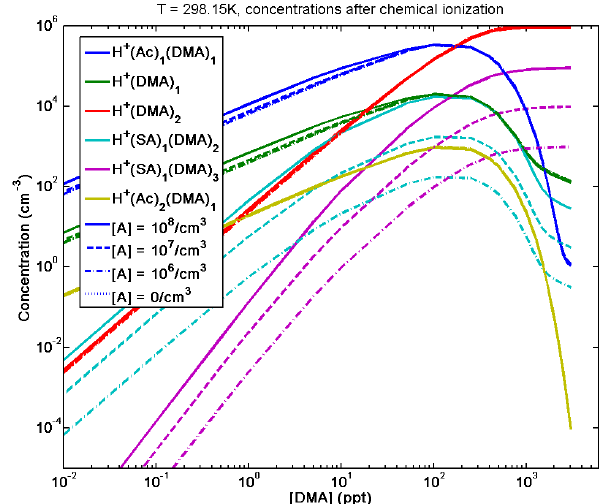
Figure 5. Modelled number concentrations of charged clusters after chemical ionization. The sticking factor was 1 for all collisions, the initial neutral acetone monomer concentration was 0cm − 3 , and the initial charger ion concentration was 10 6 cm − 3